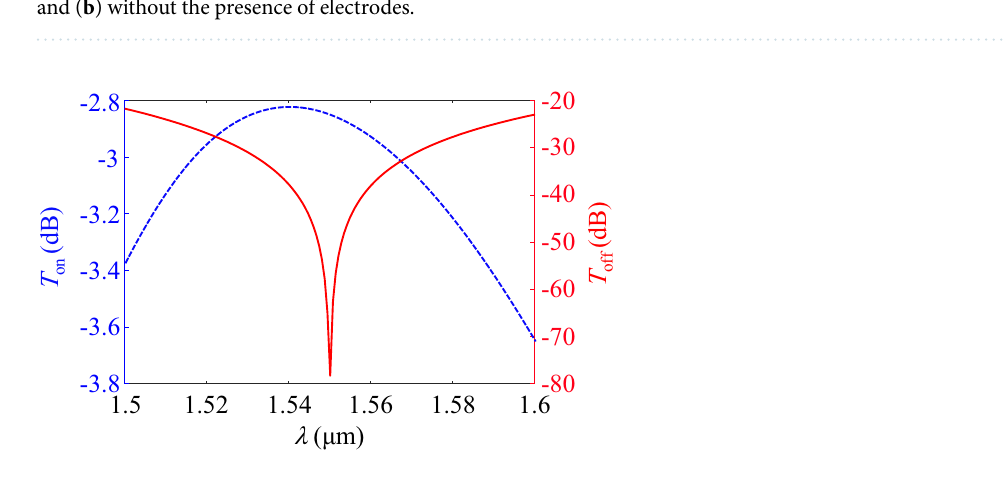
Figure 8. Transmission spectra of the proposed MZM in the on and off